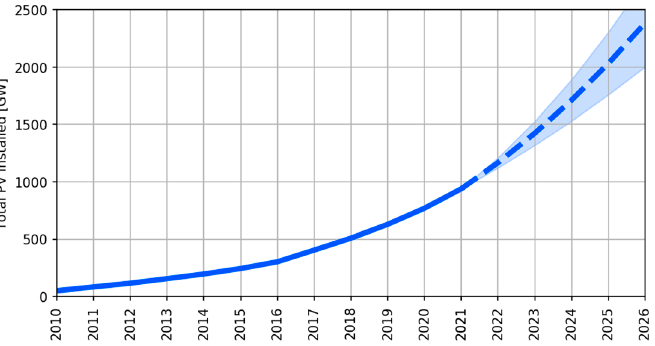
Figure 1. Total solar PV installed capacity in 2010–2021 and forecast in 2022–2026 [1].